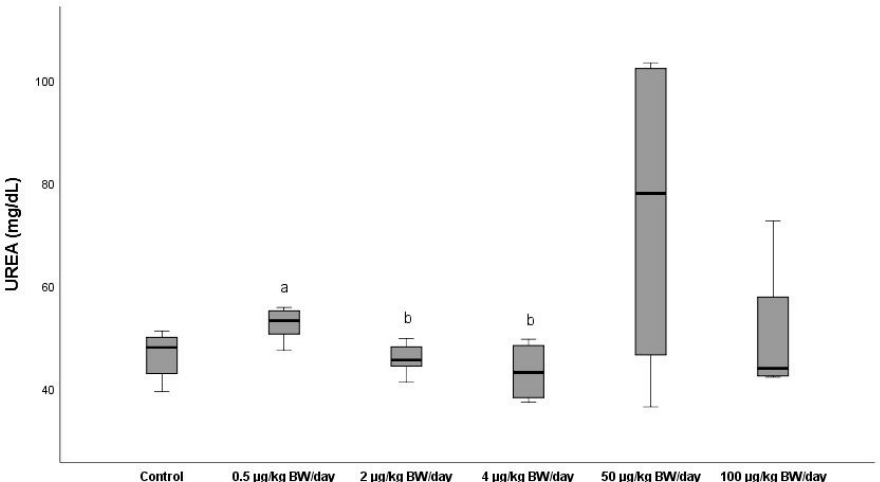
Figure 6. Means ± standard deviations of the serum levels of urea (UREA) expressed in mg/dL in the different exposure groups. a significant differences vs. control (G0) ( p < 0.05); b significant differences vs. 0.5 µg/kg BW/day (G1).